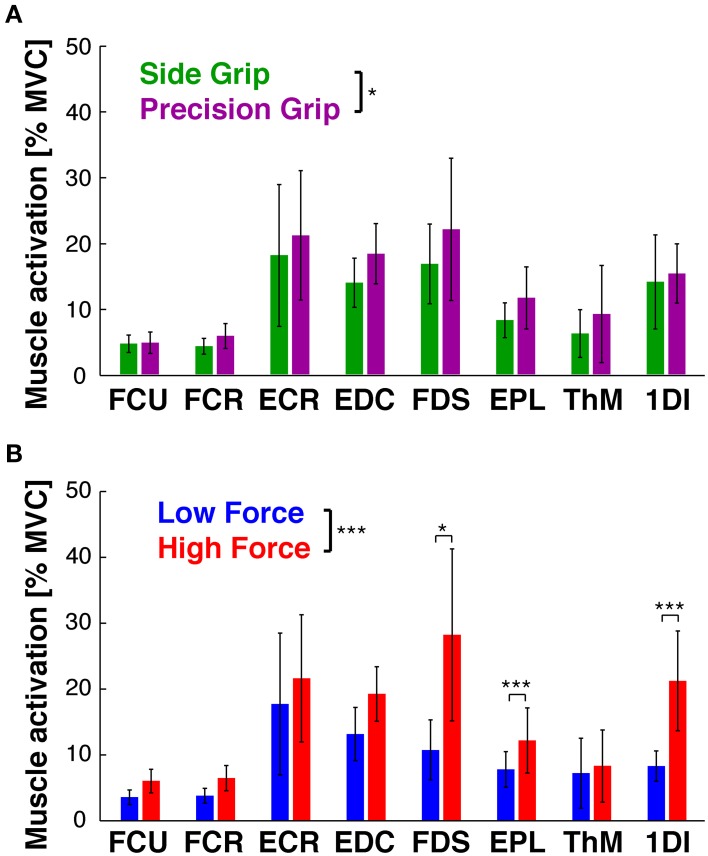
EMG as a function of task conditions. EMG during Hold, averaged across subjects (mean ± 95% confidence interval). (A) EMGs in side (green) vs. precision grip (purple), independent of load condition. GRIP showed a significant main effect (*at legend): precision grip usually evoked higher EMG activity. (B) EMGs in low (blue) vs. high force condition (red), independent of grip type. LOAD showed a significant main effect (*** at legend), with FDS, EPL and 1DI showing significantly increased activity in post-hoc tests. *At individual EMGs: significant difference of post-hoc test at p < 0.05, **p < 0.01, ***p < 0.001.